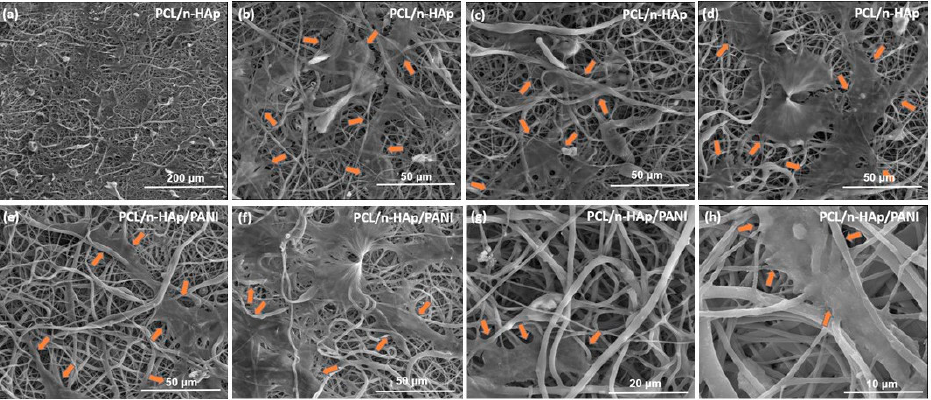
Figure 10. Scanning electron microscopy images of normal human osteoblast (NHOst) cells adhered to PCL/n-HAp ( a – d ) and PCL/n-HAp/PANI scaffold after 7 days of cell culture. The edges of growing cells are marked with arrows ( e – h ).